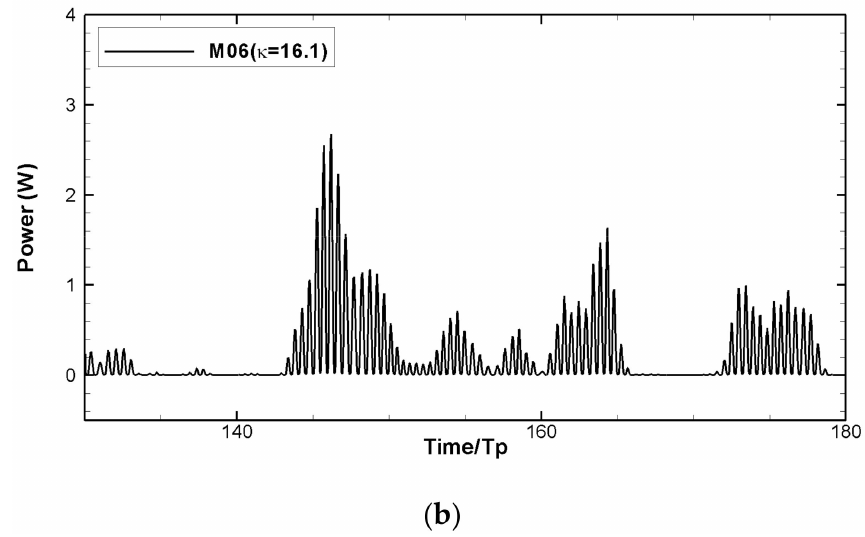
Figure 16. Time series of heave motion response and extracted power for different PTO damping in irregular waves ( H 1/3 = 0.098 m, ω P = 3.0 rad/s); ( a ) Heave motion; ( b ) Extracted